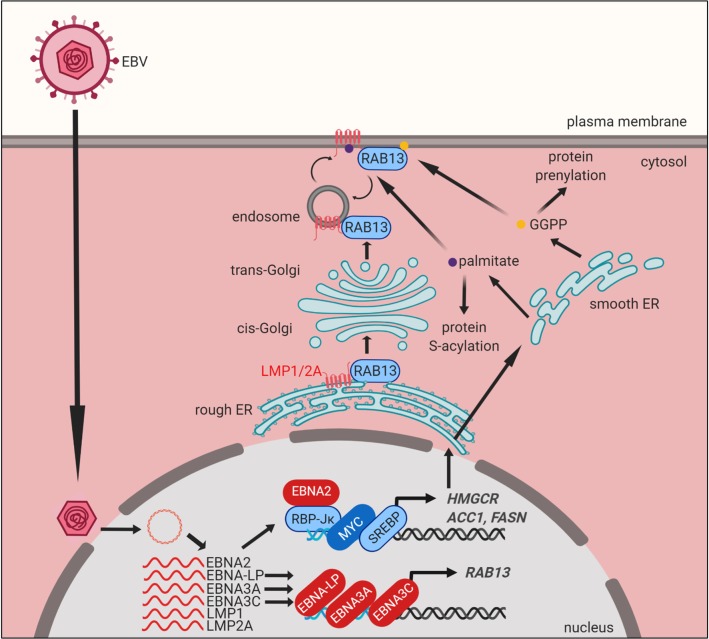
Model of EBV-induced cholesterol and lipid biosynthesis pathways remodeling and roles in LMP trafficking.EBV-encoded EBNA2 targets growth-promoting transcription factors such as MYC and SREBPs, which together with EBNA2 drive expression of key lipid biosynthesis genes. These metabolic programs induce mevalonate and fatty acid synthesis for B-cell remodeling and post-translational activation of target proteins. Acetyl-CoA-derived GGPP supports Rab geranylgeranylation and phospholipid synthesis. EBNA3C upregulates Rab13 expression, which then serves key chaperone roles in LMP1 and 2A trafficking and signaling.